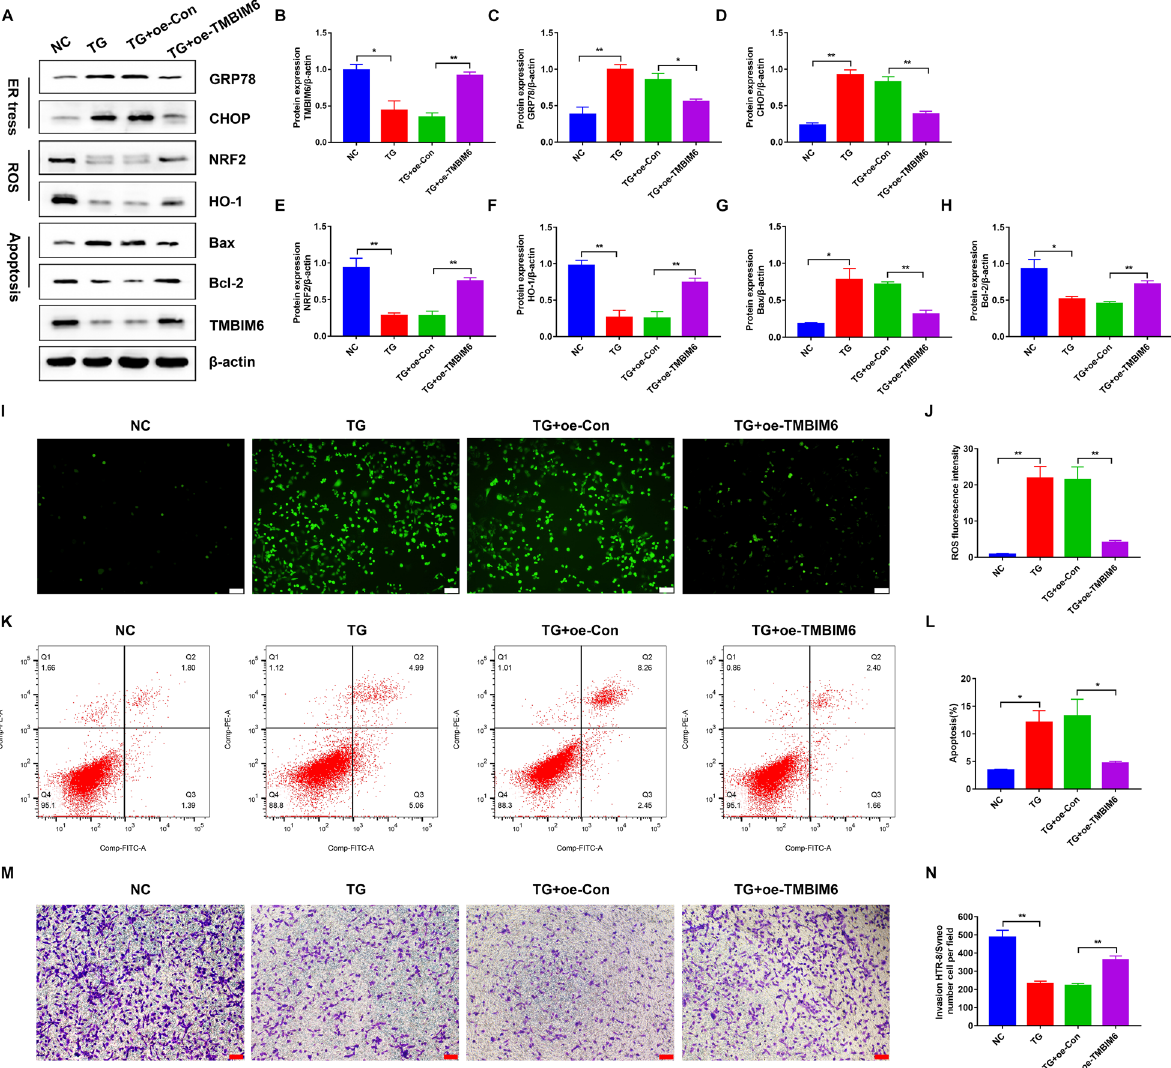
Fig. 5 Attenuated TG-induced ER stress, oxidative stress and apoptosis in HTR-8/SVneo cells by overexpressing TMBIM6. A – H Representative WB images and densitometry quantification of TMBIM6, GRP78, CHOP, NRF2, HO-1, Bax and Bcl-2 in different groups. The data were normalized to β-actin. I , J ROS production detected by DCFH-DA. Photographs were obtained at 100 detected by flow cytometry. M Representative transwell photos of HTR-8/SVneo cells in different groups (100 Qualified data shown in M. Oe-Con: Overexpression of control plasmid; Oe-TMBIM6: Overexpression of TMBIM6 plasmid. n